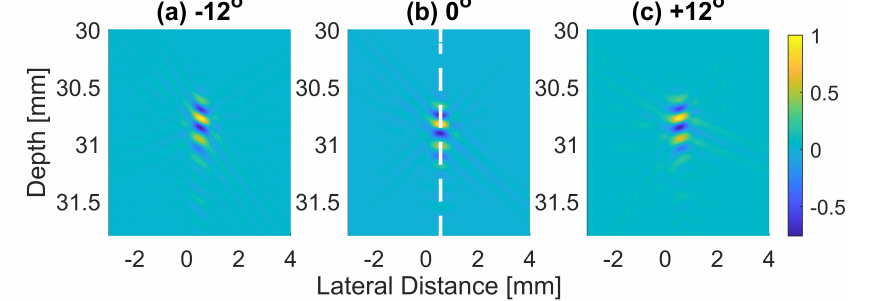
Figure 3. The received RF signals beamformed with DAS (before envelope detection and log com- pression) for a wire target with plane waves steered at ( a ) − 12 ◦ , ( b ) 0 ◦ and ( c ) + 12 ◦